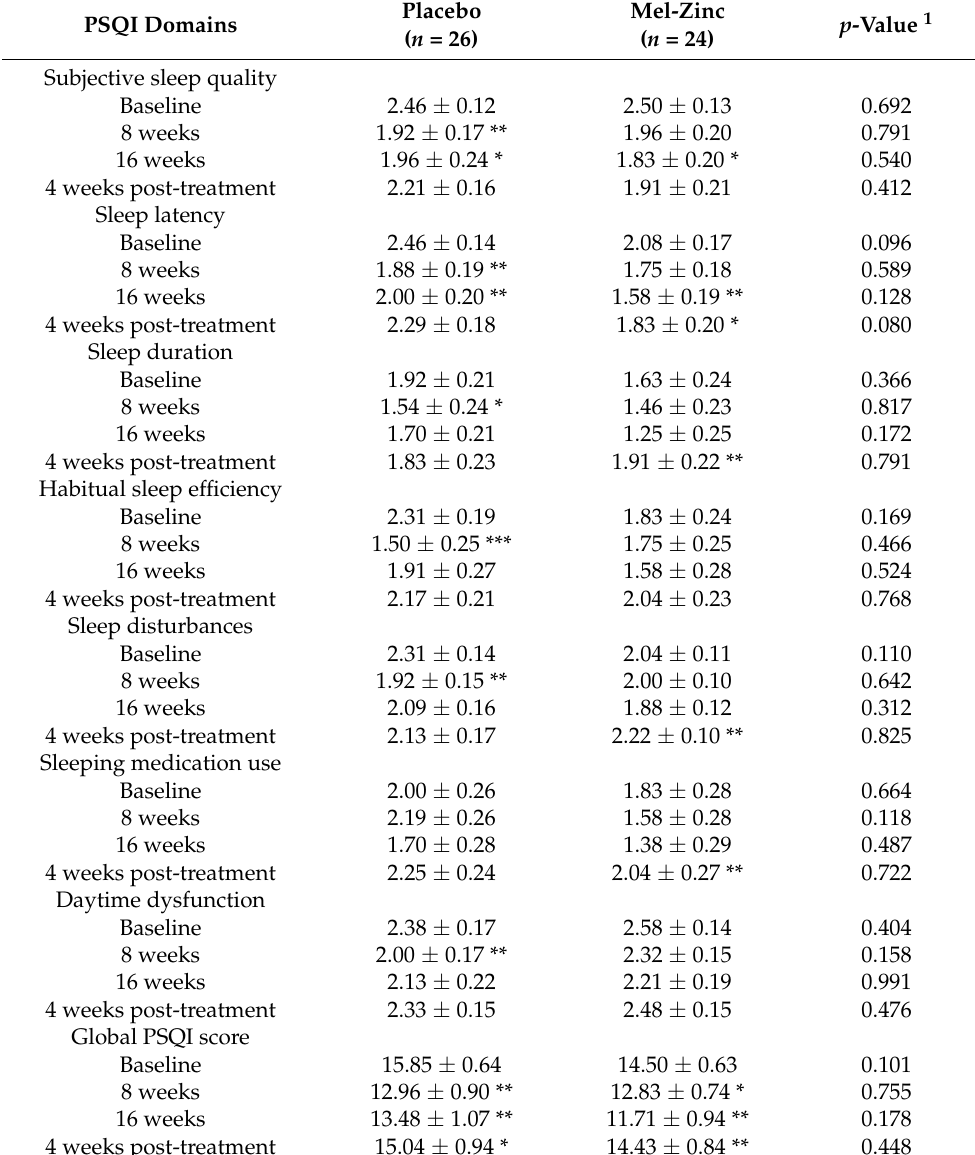
Table 3. Sleep quality (assessed with the PSQI questionnaire) in participants completing the final